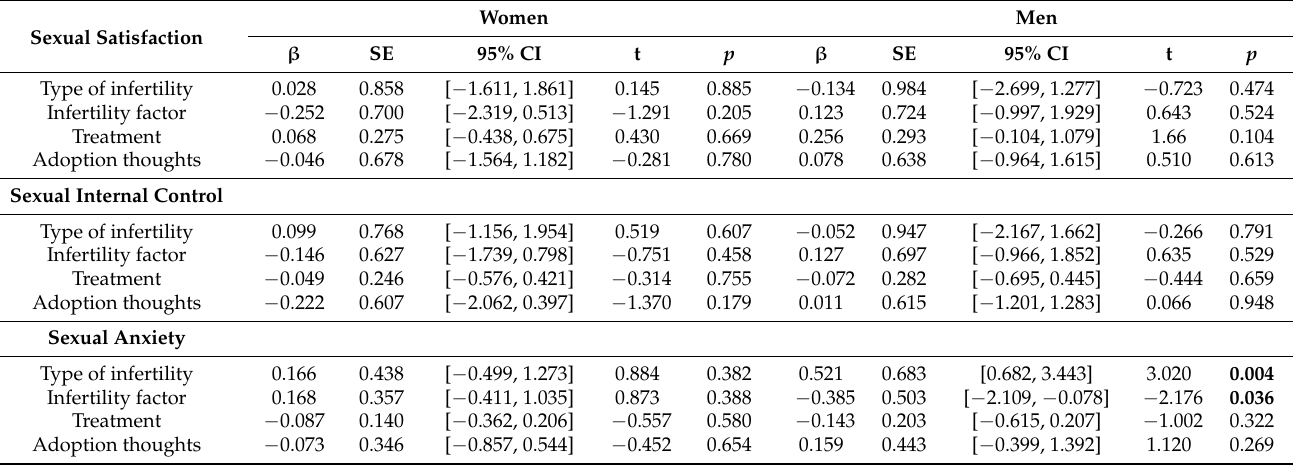
Table 5. Linear regressions with sexual dimensions as dependent variables and infertility aspects as independent